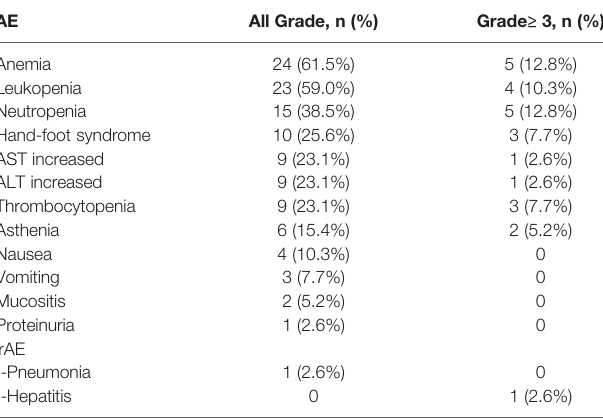
TABLE 3 | Treatment-Related Adverse Events.